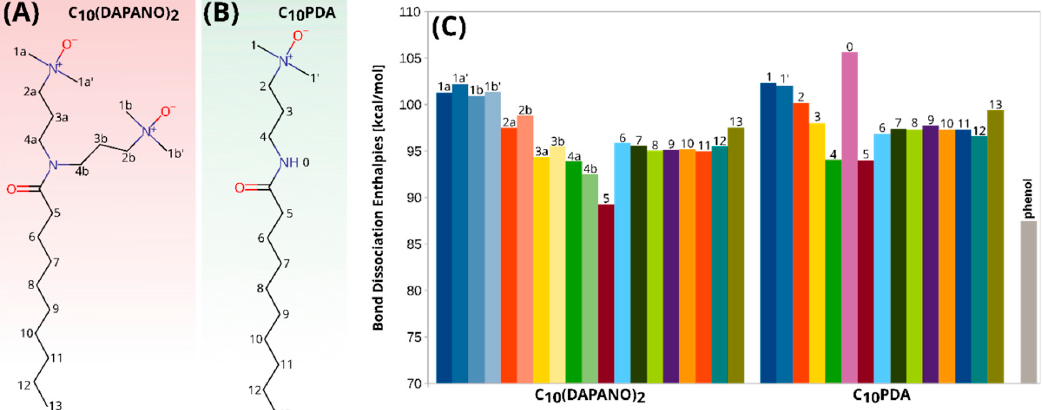
Figure 7. Labeling of atoms forming bonds with hydrogens in C 10 (DAPANO) 2 and C 10 PDA molecule in ( A , B ), respectively, along with dissociation enthalpies calculated for these bonds at the DLPNO-CCSD(T)/ cc-pVTZ level at 298 K ( C ). The results of the B3LYP/def2-TZVP, B2PLYP/def2-TZVP and M06-2X/def2-TZVP calculations are given in Table S1. For comparison, BDE for phenol is shown.